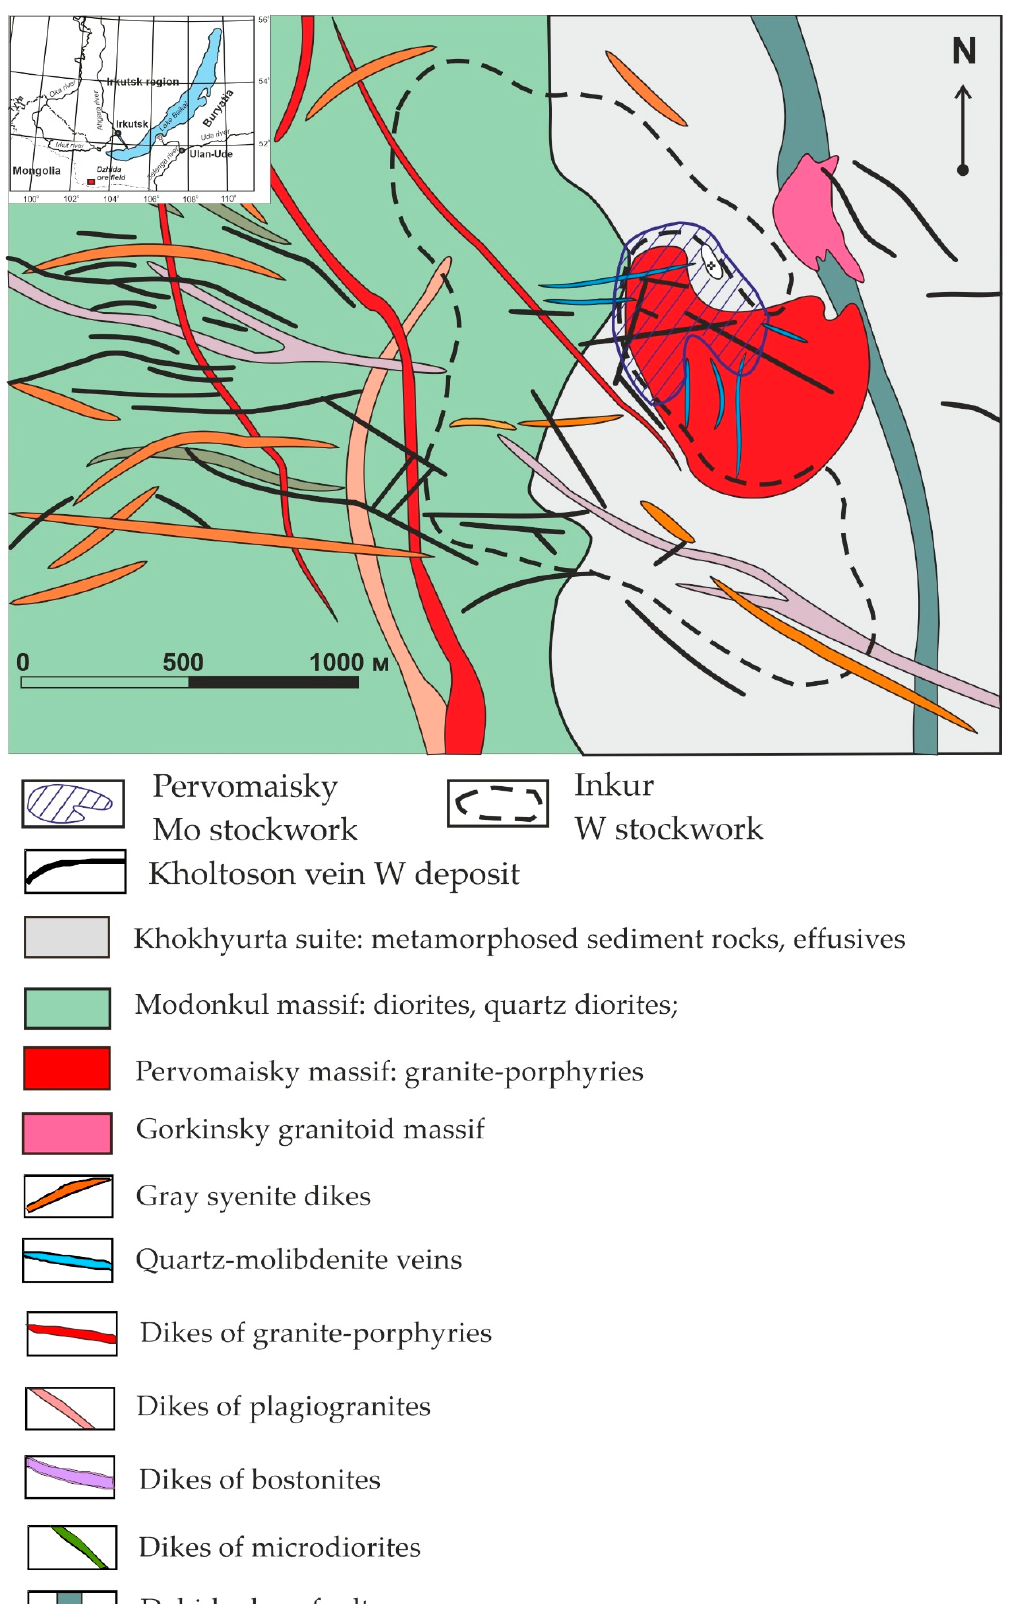
Figure 1. Simplified geological map of the Dzhida ore field (according to V. I. Ignatovich, 1975).